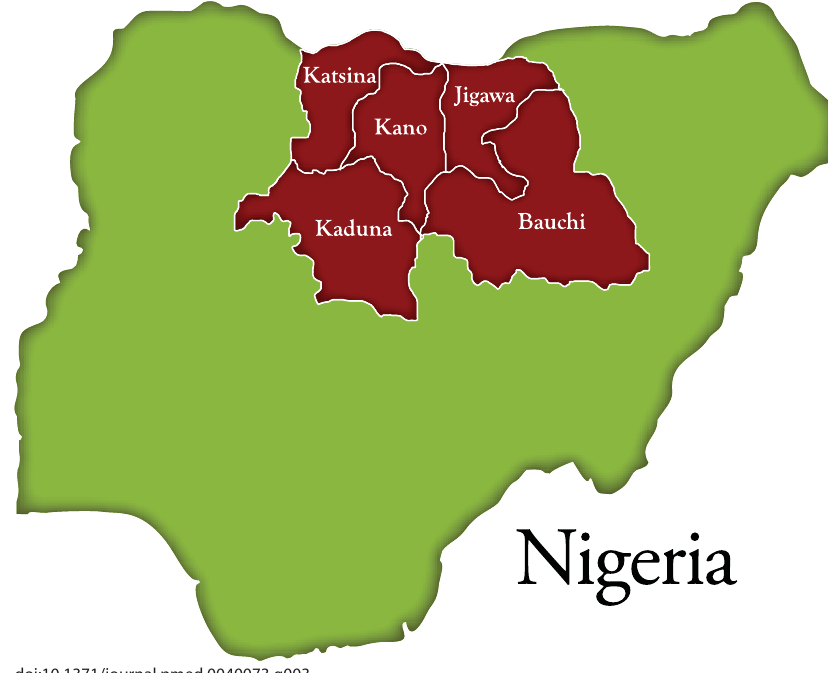
Figure 3. The Five States in Northern Nigeria That Accounted for 51% of All Polio Cases Worldwide in 2006 (Illustration: Anthony Flores; data derived from http://www.polioeradication.org/content/